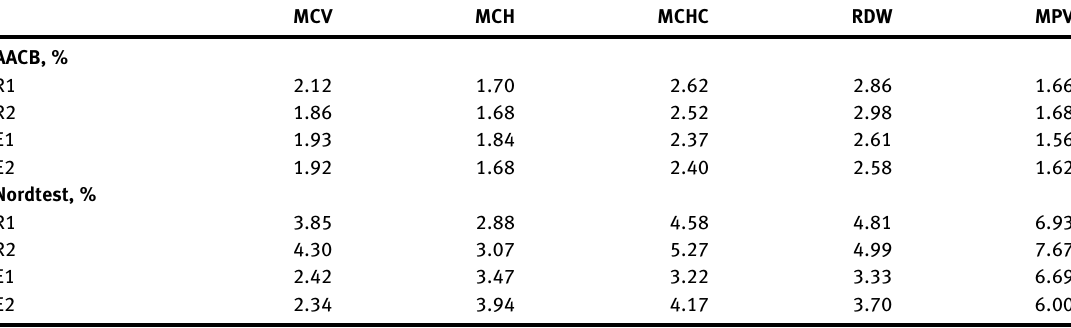
Table  : Measurement uncertainty percentages of MCH, MCHC, MCV, MPV,